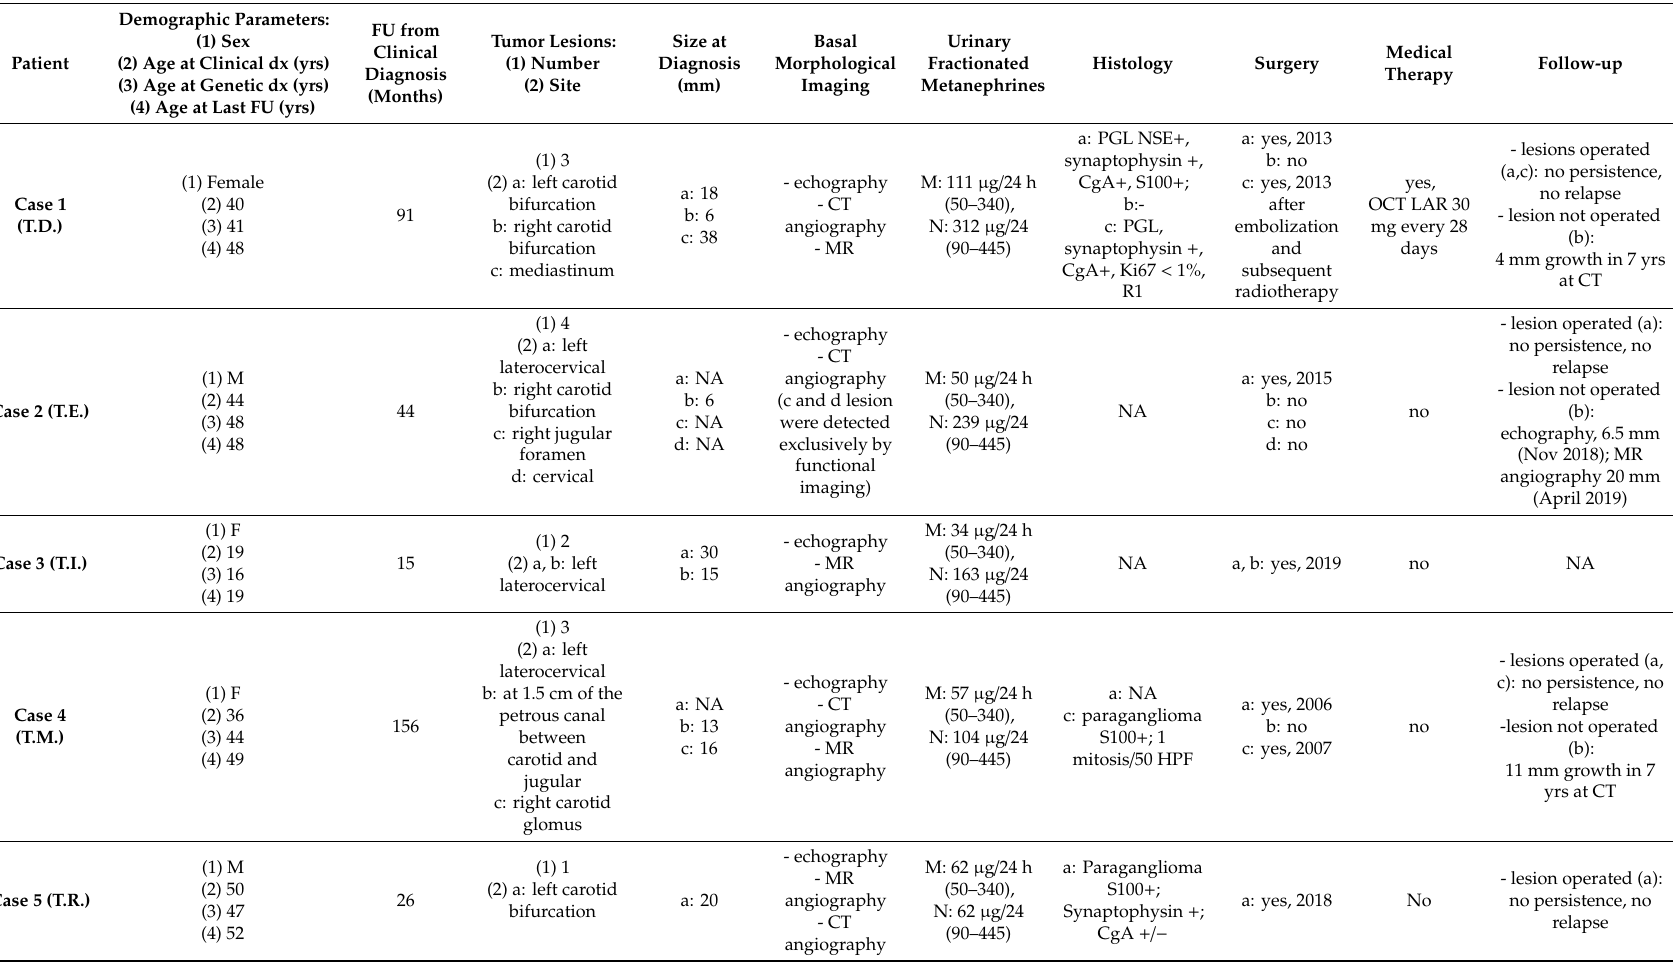
Table 1. Clinical characteristics. Abbreviations: yrs = years; dx = diagnosis; FU = follow-up; NA = not available; M = metanephines; NM = normetanephrines; CT = computed tomography; MR = magnetic resonance; PGL = paraganglioma; NSE = neuron specific enolase; CgA = chromogranin A; HPF = high-power field; OCT =